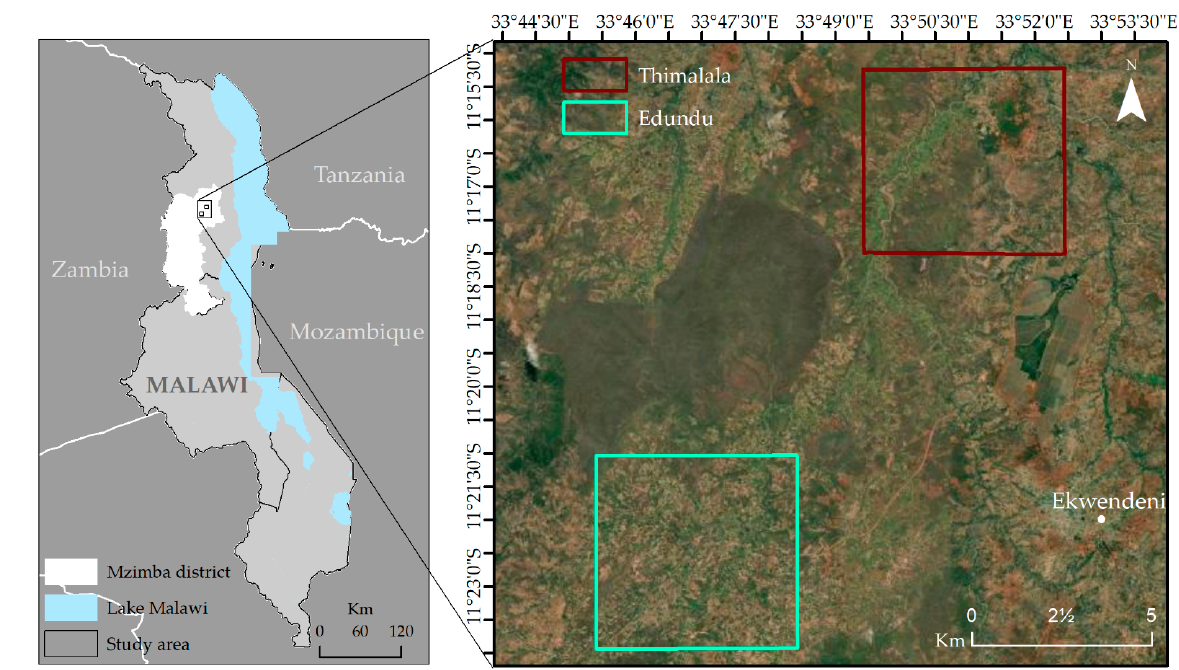
Figure 1. A general overview of the study area in the northern part of Malawi.